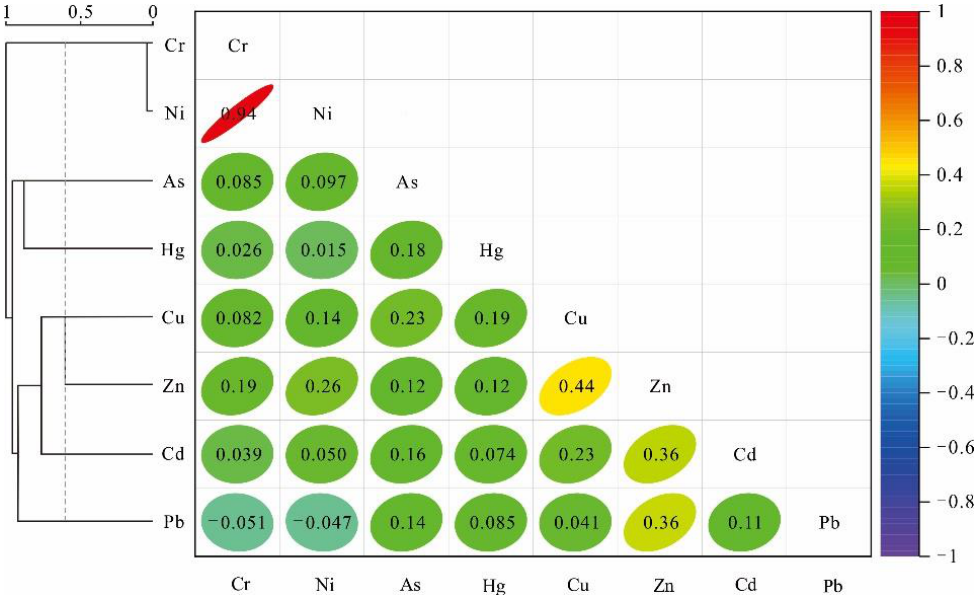
Figure 4. Correlation plot of eight heavy metals in the study area.